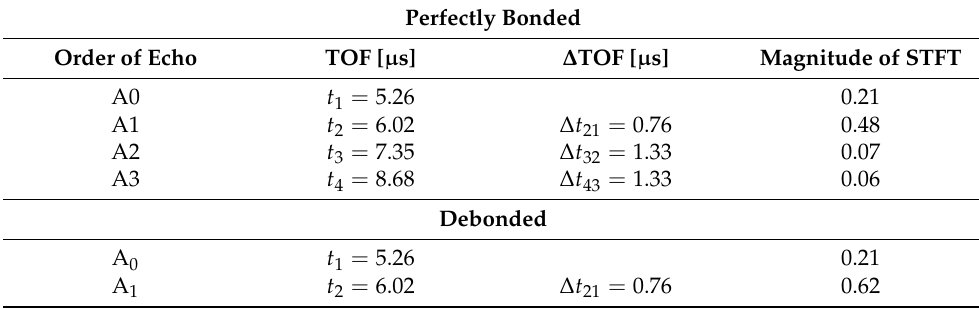
Table 3. Estimated properties of the signal from a perfectly bonded and debonded layer of epoxy A.